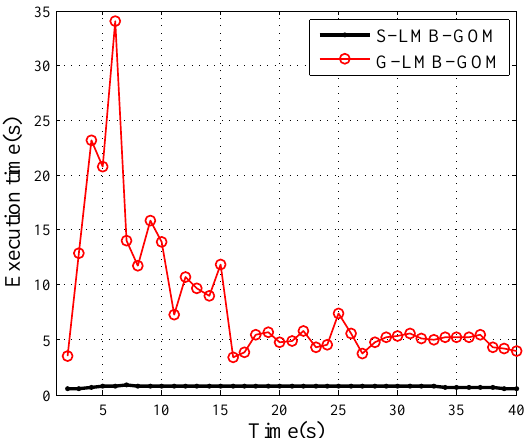
Figure 11. The execution time per frame for S-LMB-GOM filter and G-LMB-GOM